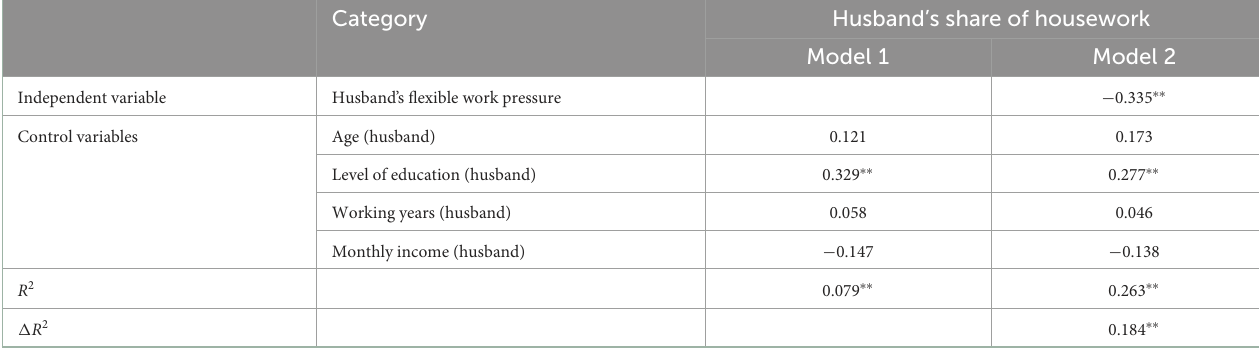
TABLE 4 Test results of direct effect of husband’s elastic stress and the husband’s share of